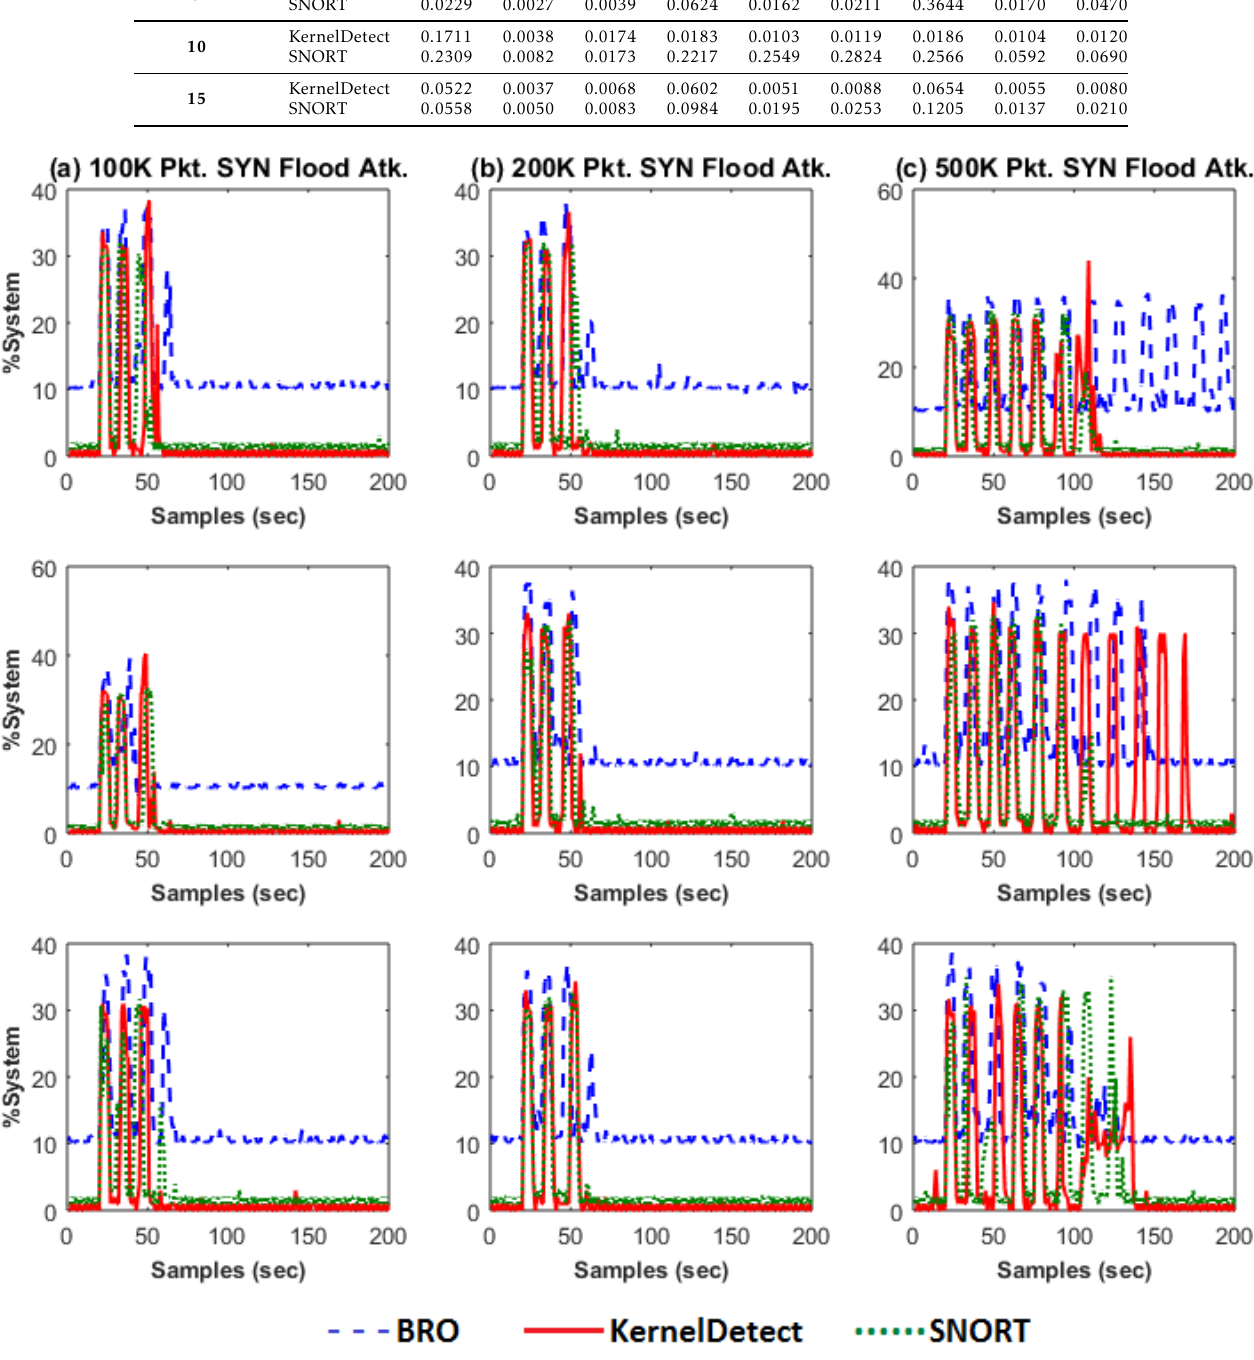
Figure 12. System usage at 100K, 200K, and 500K packets (Pkt.) loads of SYN flood attack